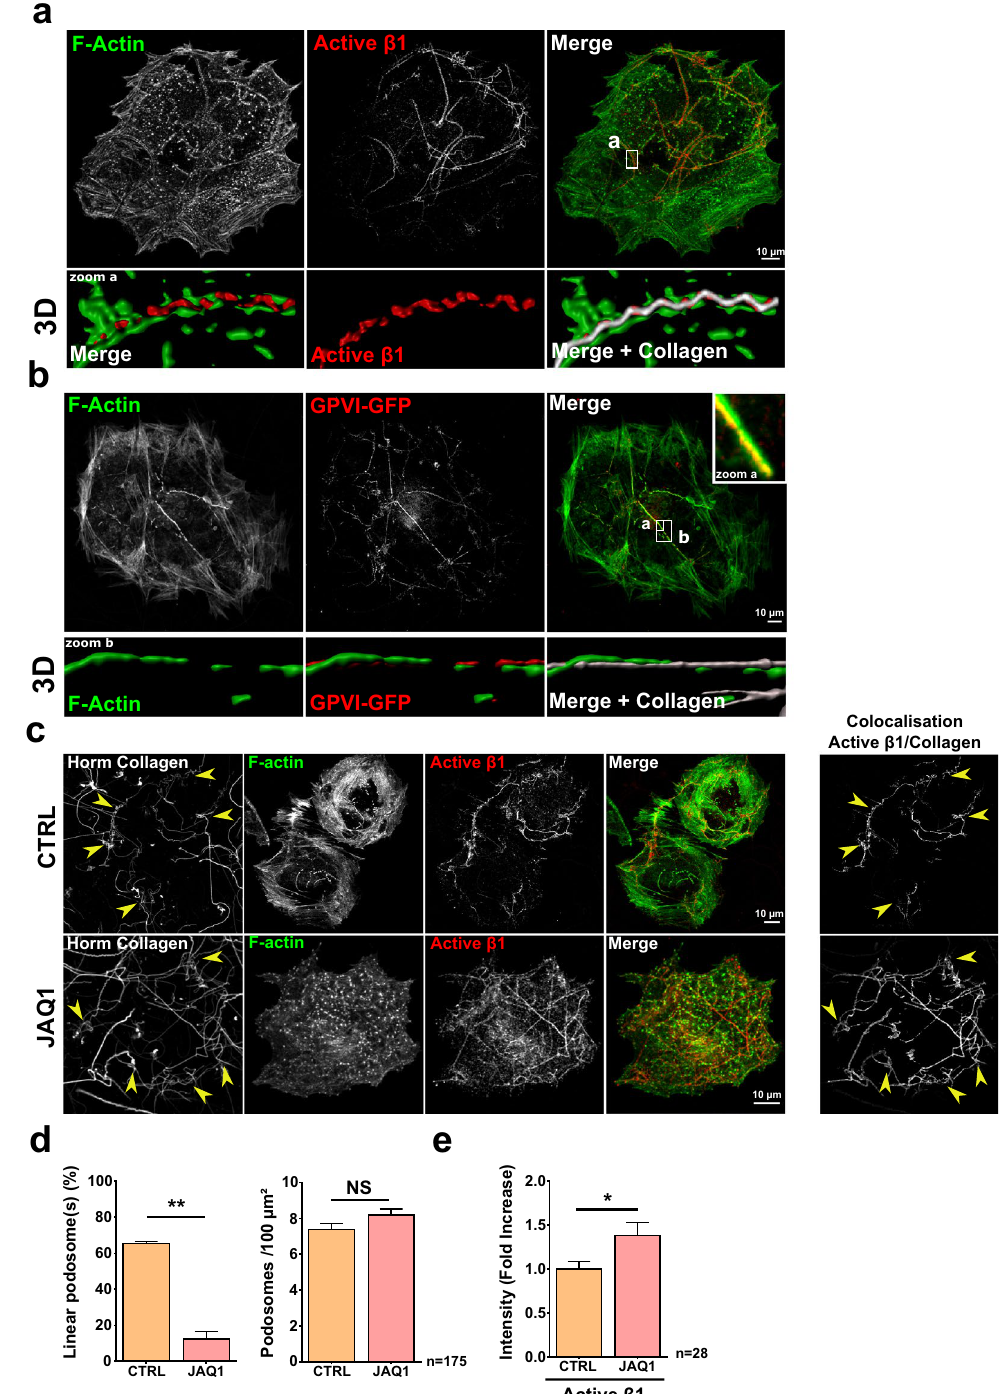
Figure 7. GPVI and the ß1 integrin act as collagen I receptors to generate linear podosomes. ( a ) Representative confocal image of mature MKs cultured for 6 h on 100 µg/ml Horm Collagen, prior to fixation and staining for active ß1 (red) and F-actin (green). 3D corresponds to 3D surface rendering done with the IMARIS software. Scale bar = 10 µm. ( b ) hGPVI-eGFP (red) lentivirus transduced MKs were treated as in ( a ). Zoom a shows a linear podosome above a linear collagen fiber. Zoom b is a 3D surface rendering of the collagen, linear podosome and GPVI-GFP reconstruction using the IMARIS Software. Scale bar = 10 µm. ( c ) CTRL (control) and JAQ1 (GPVI blocking antibody, 10 µg/ml)-pretreated D3MKs were cultured on 100 µg/ ml labeled-Horm Collagen, fixed and stained for active ß1 (red) and F-actin (green). Yellow arrows indicate Collagen tangled clumps. Image rendering of the colocalization of active ß1 and Collagen fibers performed as described in “Methods” is shown. Scale bar = 10 µm. ( d ) Quantification of linear podosomes and dot-like podosomes (podosomes) density (for 100 µm 2 ) in D3MKs. ( e ) CRI and fluorescence intensity measurements from active ß1 on collagen fibers with or without JAQ1 treatment. Values (mean ± S.E.M.) are from 5 independent experiments. *P < 0.05, **P < 0.01, NS not significant according to the Mann– Whitney test. n = number of cells